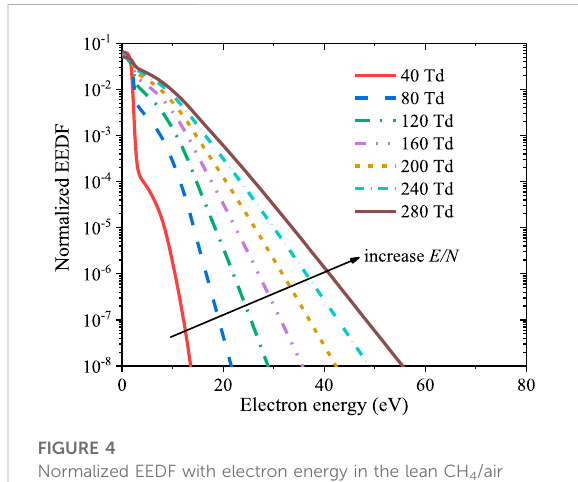
FIGURE 4 Normalized EEDF with electron energy in the lean CH 4 /air mixture.